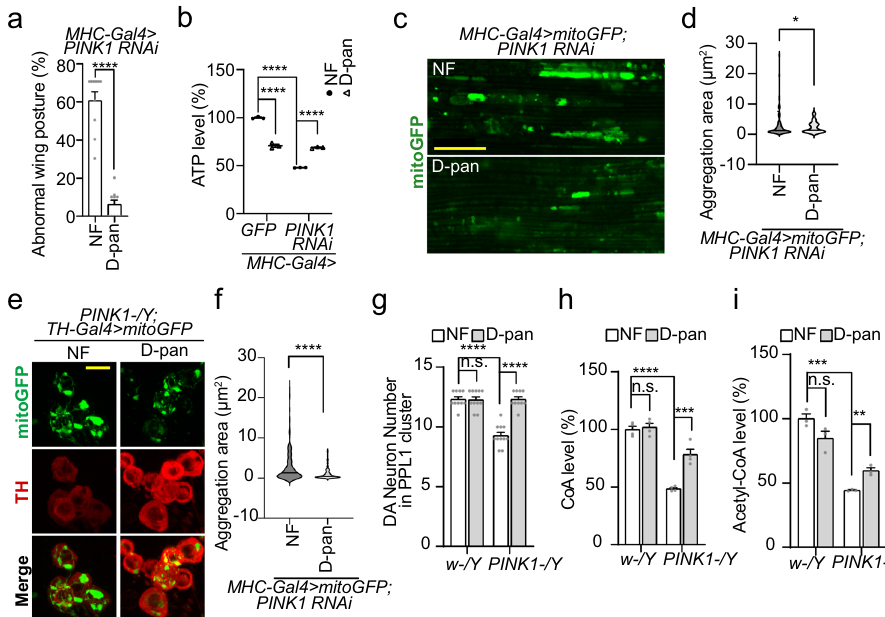
Fig. 3 D-pantethine Rescues PINK1 LOF Defects. a Rescue of D-pantethine (D-pan) alimentation on wing posture defect in PINK1 RNAi fl ies. 25 fl ies per genotype per group were tested, n = 10 biologically independent groups. In this and following fi gures in Fig. 3, NF, as normal food. b Effects of D-pan alimentation on ATP levels in WT and PINK1 RNAi fl ies. UAS-GFP serves as control. n = 3 biologically independent samples. c , e Immunostaining showing effects of D-pan alimentation on mitochondrial aggregations in fl ight muscle ( c ) and DA neurons ( d ) caused by PINK1 LOF. Scale bars: ( c ) 25 µ m; ( d ) 10 µ m. d , f Violin plots showing the quanti fi cations corresponding to ( c ) and ( e ). The signi fi cance was calculated by using two-proportion Z test, and thresholds were set at 8 µ m 2 ( d ) and 3 µ m 2 ( e ); n = 3 biologically independent samples. g Rescue of D-pan alimentation on DA neurons loss in PPL 1 cluster of PINK1 mutants. n = 9 ( w- /NF, PINK1 /D-pan), n = 10 ( w- /D-pan, PINK1 /NF) biologically independent animals. h , i Effects of D-pan alimentation on CoA and acetyl-CoA levels in WT ( w-/Y ) and PINK1 mutant. n = 4 biologically independent samples in assay ( h ) n = 3 biologically independent samples